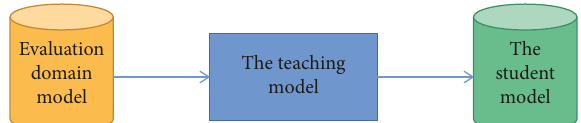
Figure 3: The relationship between the domain model, the teacher model, and the student